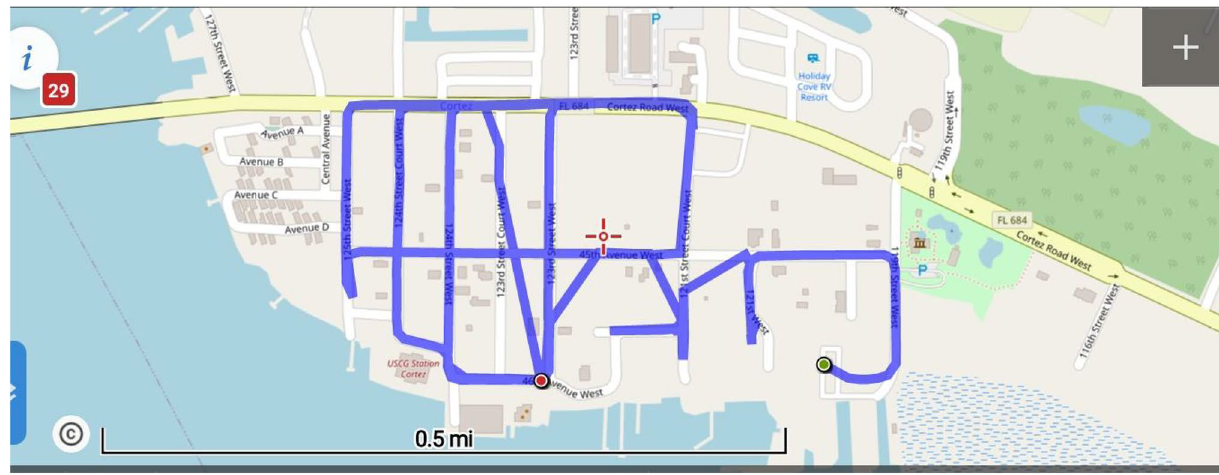
Fig. 3 Aerial overview of experimental sites in Cortez, Florida, Man- atee County. Top Left: Control site larval jar locations. Top Right: Treatment site larval jar locations. Bottom Left: Control site sur-